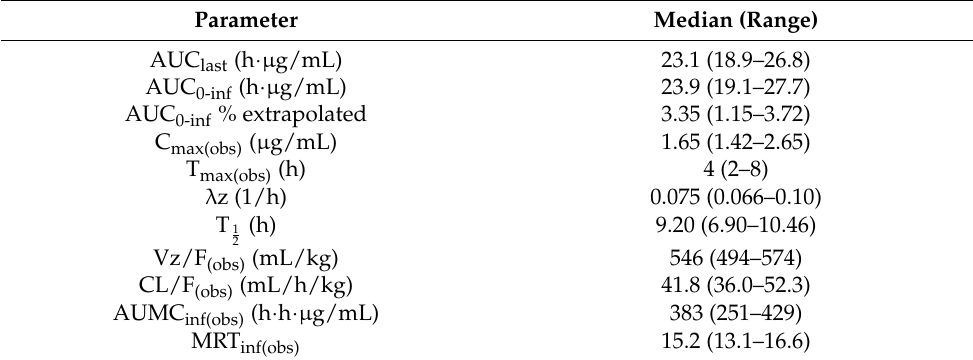
Table 3. Median (range) non-compartmental pharmacokinetic parameters estimated for sheep (n = 6) administered 10 daily oral 1 mg/kg doses of meloxicam.